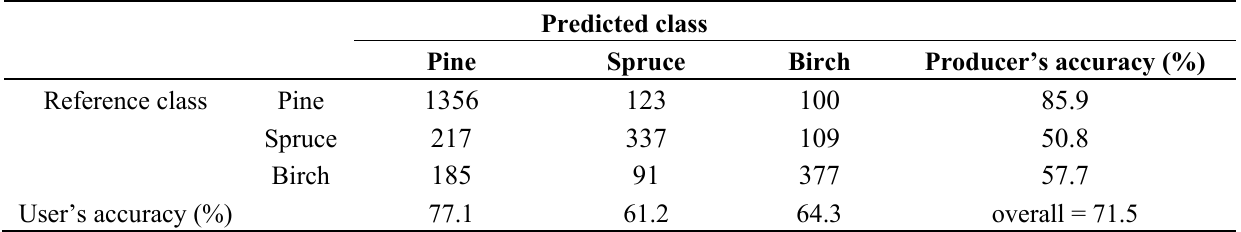
Table 6. Error matrix and accuracy of the classification with solely FWF